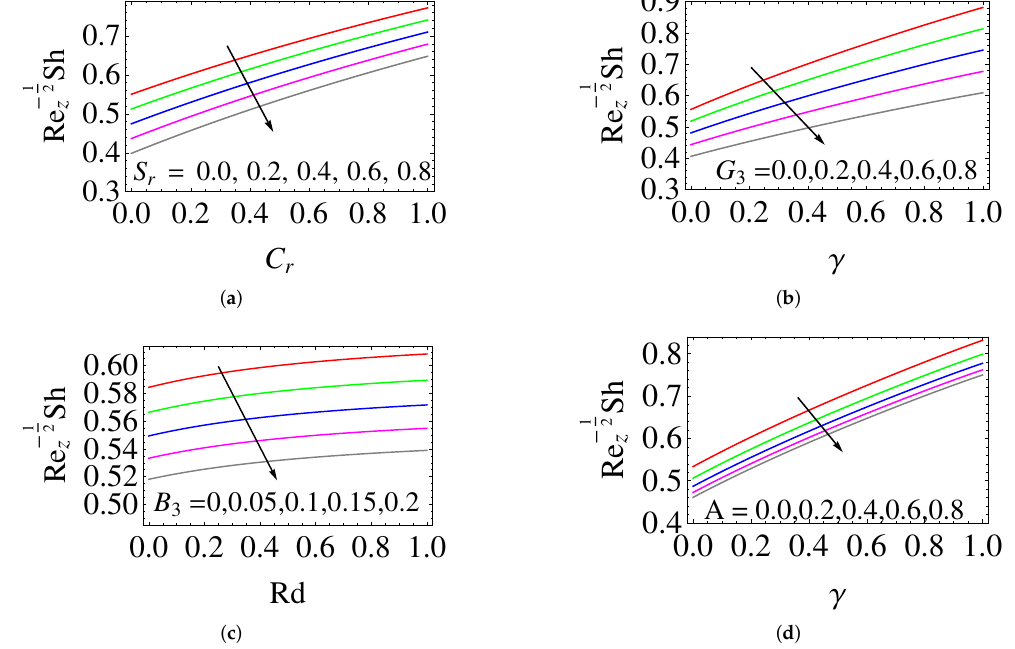
Figure 13. Influences of ( a ) Soret number ( S r ) , ( b ) concentration stratification ( G 3 ) , ( c ) thermal slip ( B ) and ( d ) velocity slip ( A ) parameters on Sherwood 3